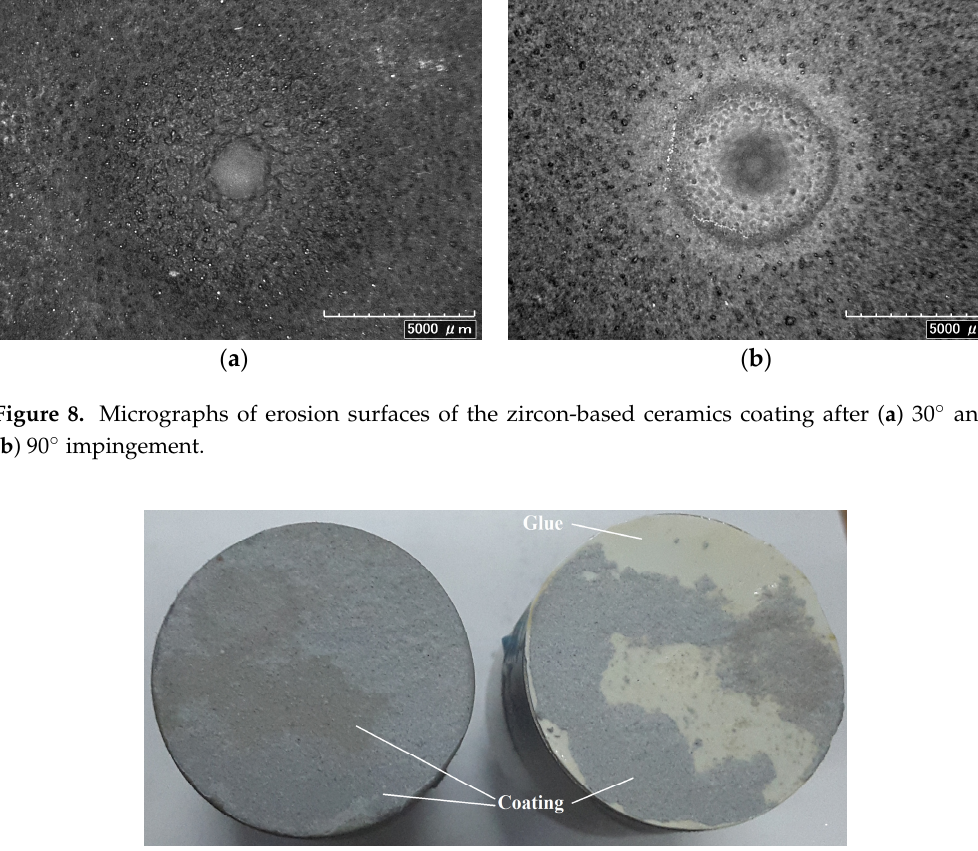
Figure 8. Micrographs of erosion surfaces of the zircon ‐ based ceramics coating after ( a ) 30 ° and ( b ) 90 ° impingement.